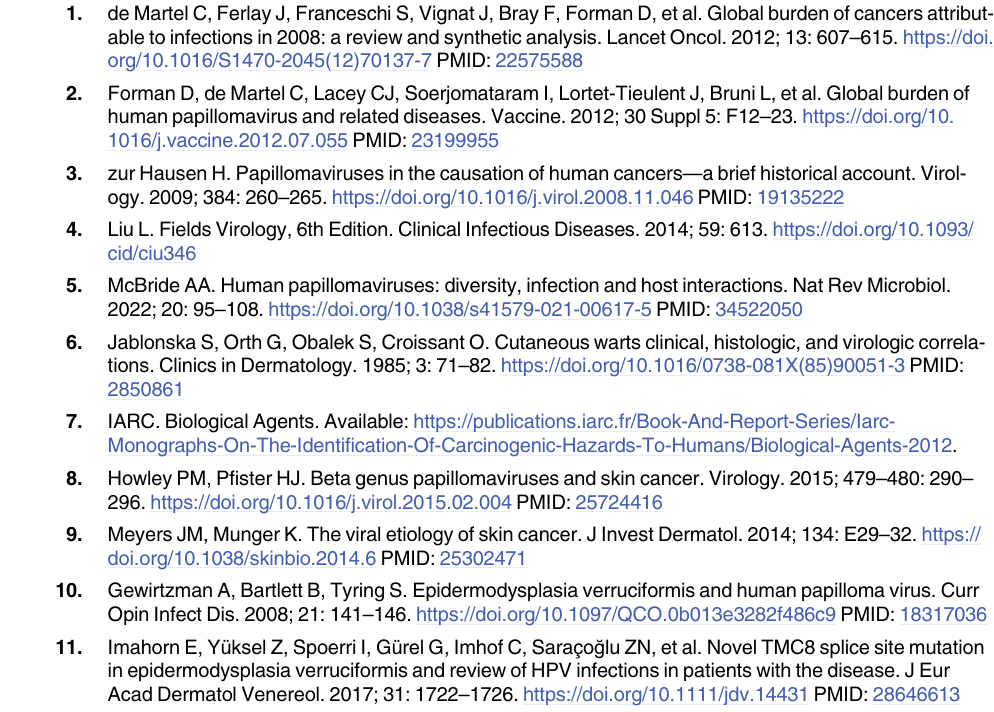
S8 Fig. Schema for IF quantification. The workflow that was used for IF quantification of dif- ferentiation markers is